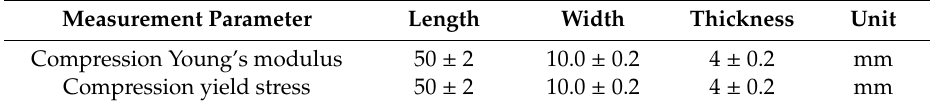
Table 4. Test specimen dimensions for the characterization of PETG under compressive stress state.